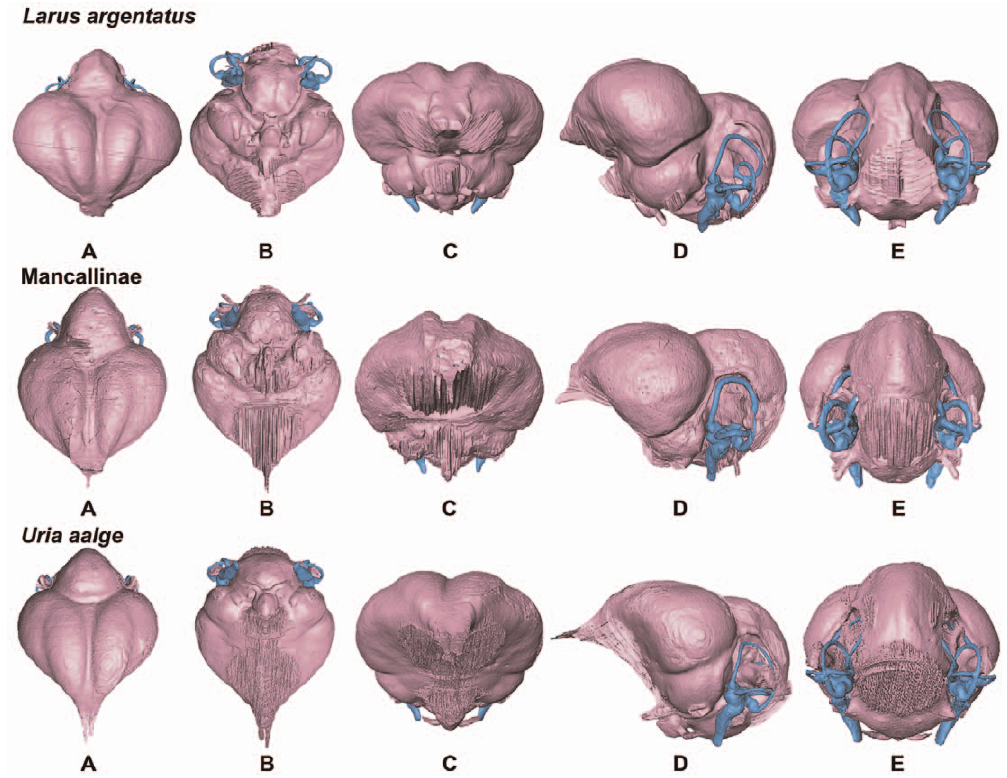
Figure 9. Endocasts of the Herring Gull Larusargentatus , Mancallinae sp., and Common Murre Uriaaalge in dorsal (A), ventral (B), anterior (C), lateral (D), and posterior (E) views (not to scale for comparison).